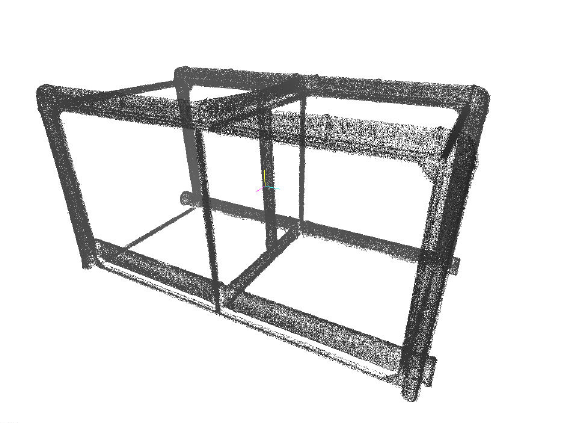
Figure 6. An 3D scan of the test structure, acquired by an Riegl VZ-400, as reference point cloud. shows experiments for the verification of geometric models for underwater camera